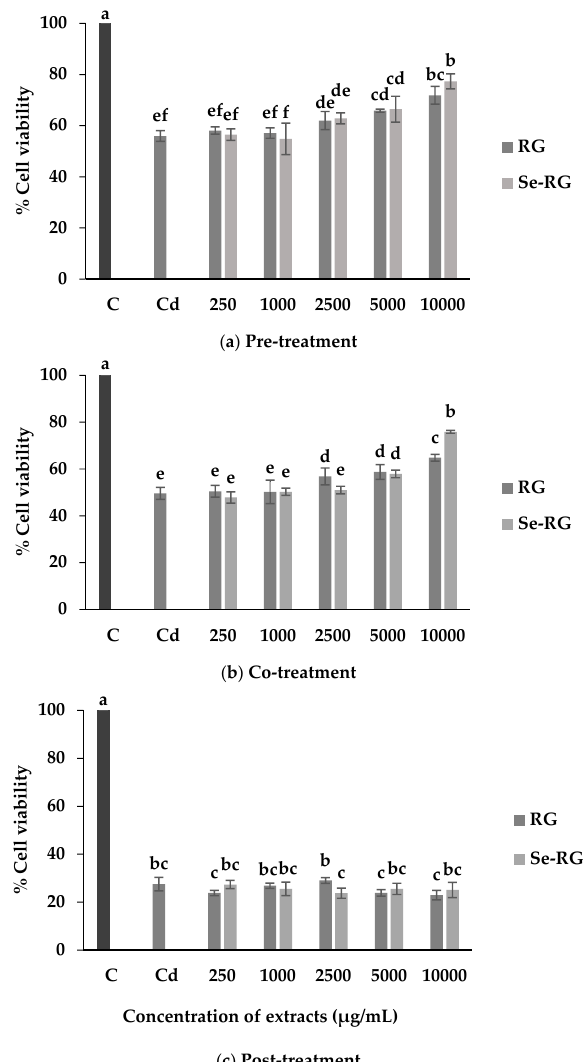
Figure 3. Anti-Cd toxicity properties of RG and Se-RG on HEK293 kidney cells while exposed to CdCl 2 at different time orders of treating the extracts compared to the control and Cd-treated ( a ) pre-incubation ( b ) co-incubation ( c ) post-incubation. C means control; Cd means CdCl 2 at CC 50 level (68.50 µg/mL). The cell viability was expressed as a percentage of control. Data are means ± standard deviation (SD). Different letters indicated significant differences ( p < 0.05) in Tukey’s significant differences test.